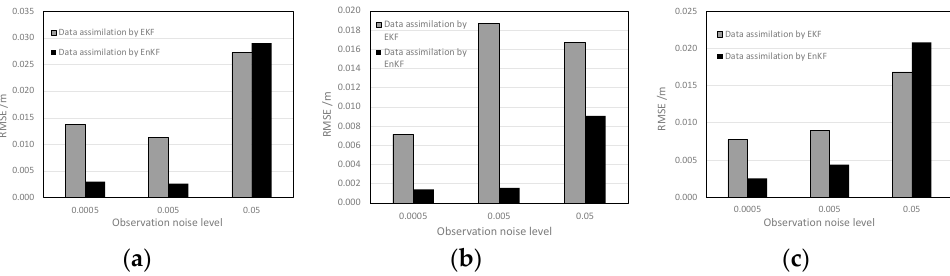
Figure 9. Comparison of RMSE values of EnKF and EKF at ( a ) Hongqiao station, ( b ) Lecheng station, and ( c ) Liushi station.